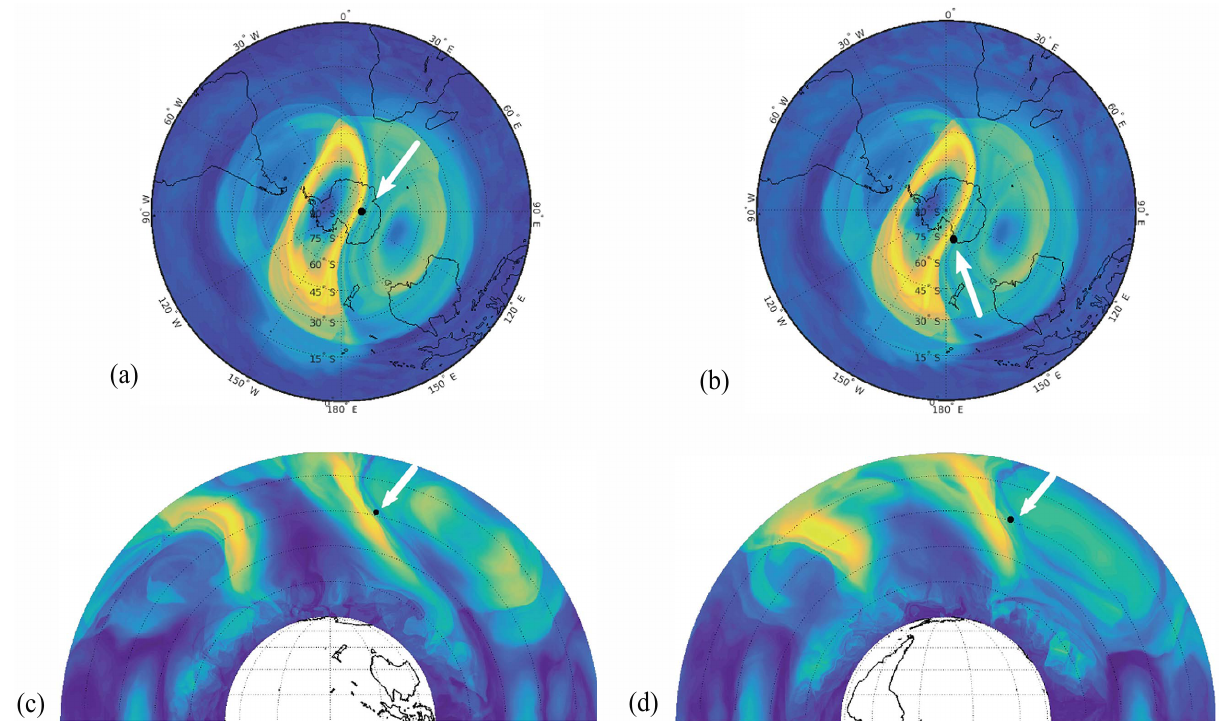
Figure 10. Evaluation of the M function with a black particle on it. (a) The black particle is placed exactly over an invariant manifold on a 2-D slice obtained at a height of 31.3km on 6 October 1979, 00:00:00UTC; (b) the same black particle on the same day and time placed on a 2-D slice obtained at longitude 90 ◦ E; (c) the same black particle 6h later on a 2-D slice of M obtained at the corresponding height of the particle at that time; (d) the same black particle 6h later on a 2-D slice of M obtained at the corresponding longitude of the particle at that